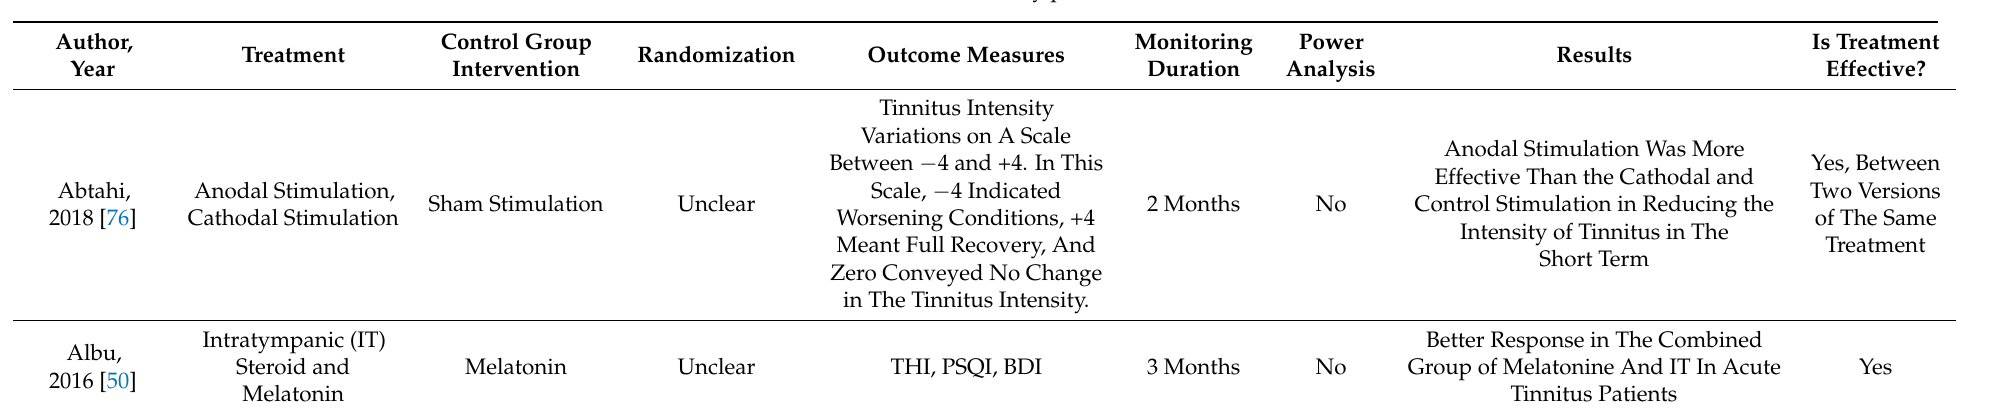
Table 2. Characteristics of included studies: study procedures and outcome